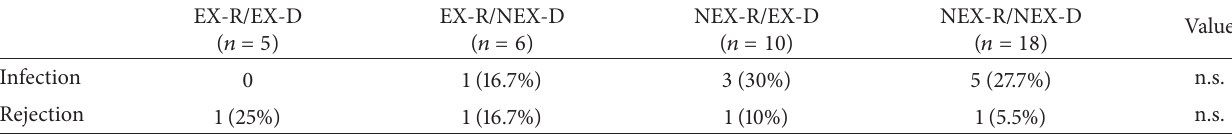
Table 3: Relationship between the patients with infectious complication or acute rejection and those divided by CYP3A5